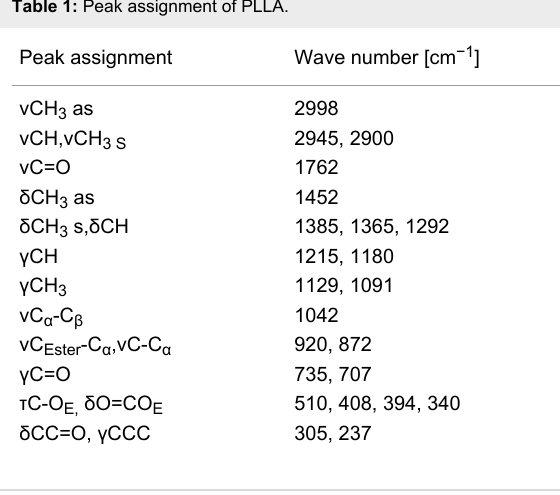
Table 1: Peak assignment of